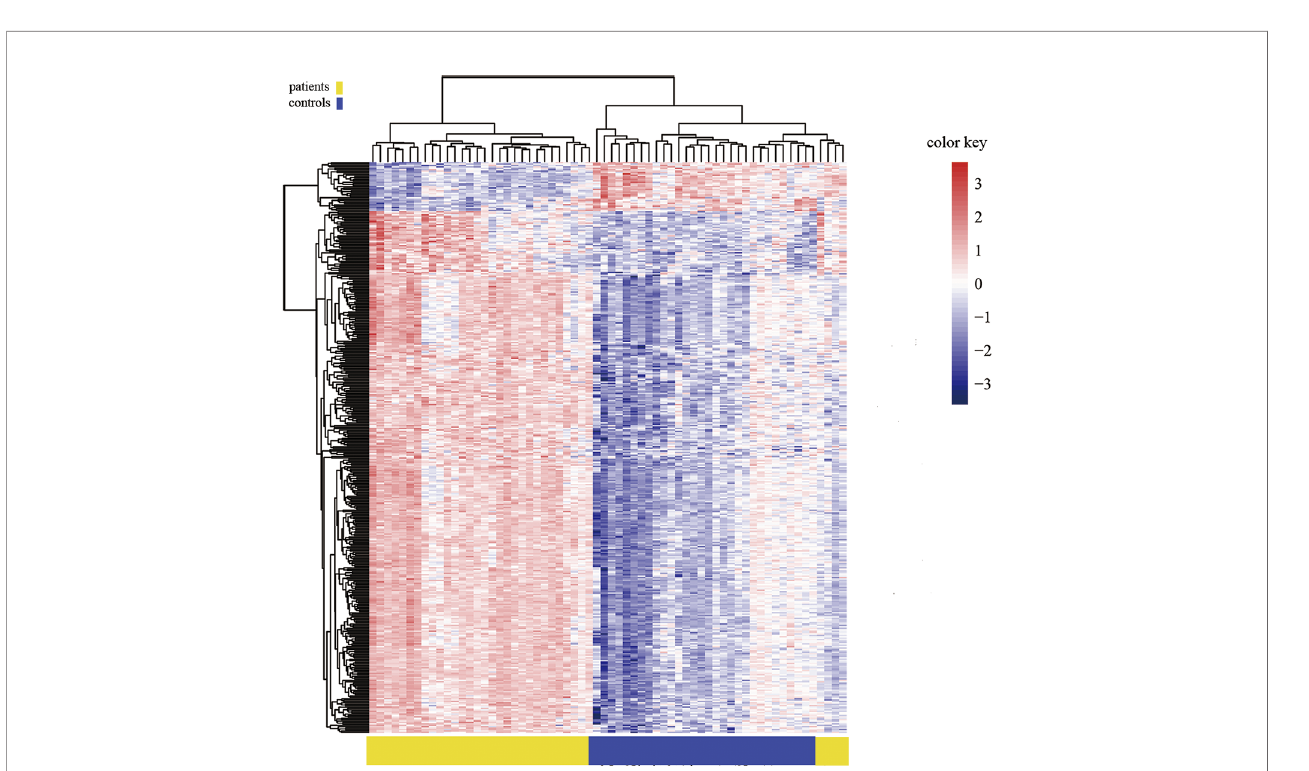
FIGURE 5 | Heat map generated from clustering-analysis of microarray data illustrating differentially methylated DNA sites in the promoter